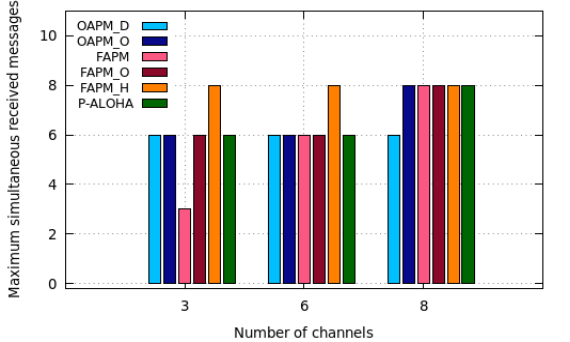
Figure 17. Maximum number of simultaneous messages received by the GW for Pure Aloha, the OAPM family and the FAPM